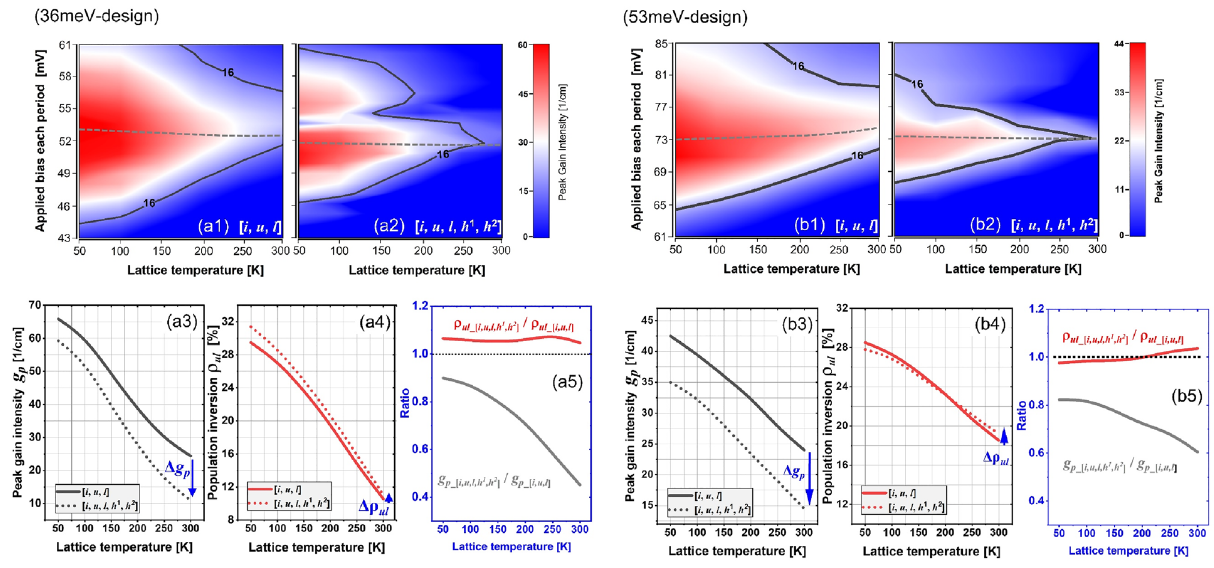
Figure 2. Peak gain mappings resolved by the lattice temperature and period applied bias from both the designs, including the mappings based on only relevant subbands, [ i , u , l ] (a1, b1) , and the mappings based on subbands including HLS, [ i , u , l , h 1 , h 2 ] ( a2 , b2 ). The black solid line boundary indicates the cavity threshold at 16 cm −1 for lasing. The gray dash line represents the bias at an operating condition. (a3, a4; b3, b4) Comparations of the peak gain g p (extracted from the gray dash line in the mappings ( a1 , a2 , b1 , b2 ) and also the population inversion ρ ul , with/without the HLS. ( a5 , b5 ) HLS-induced changing magnitude for both the peak gain and population inversion. Here, ∆ρ ul (+) denotes an increasing changing trend in the population inversion, ∆ g p (−) denotes a decreasing changing trend in the peak